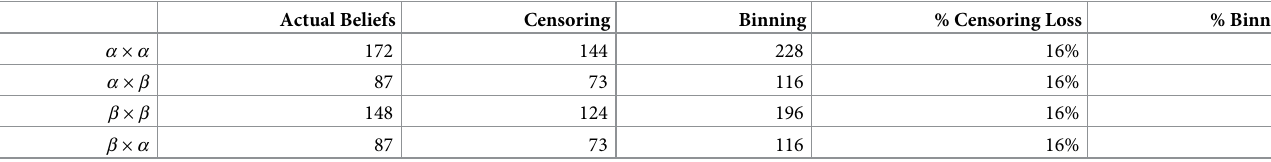
Table 3. Fisher information for Beta ( α = 0.5, β = 0.5) beliefs mapped to a